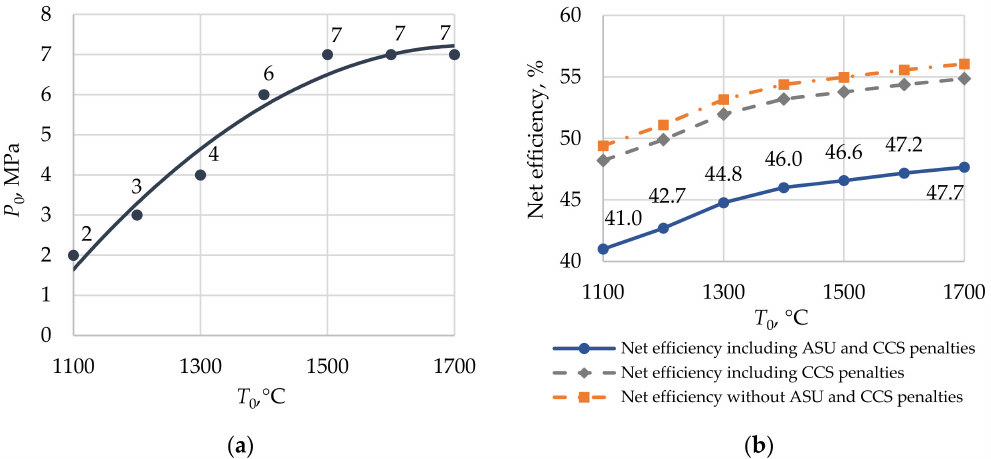
Figure 7. Optimization of the SCOC-CC initial parameters, the cooling losses include the following: ( a ) optimal turbine inlet pressure; ( b ) influence of the initial parameters on the net efficiency.